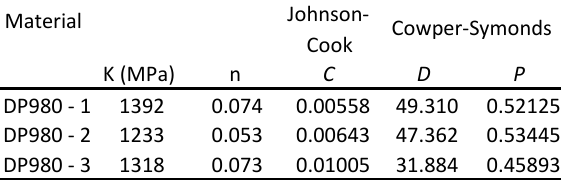
Table 1 . Model constants for the Holloman equation, JC and CS models.